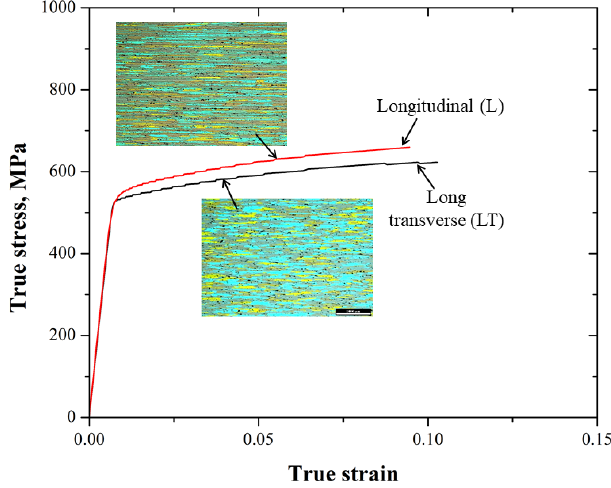
Figure 5. True stress–strain behavior for the 7075-T651 aluminum alloy (longitudinal and long transverse directions). Table 2. Tensile mechanical properties of the 7075-T651 aluminum alloy.